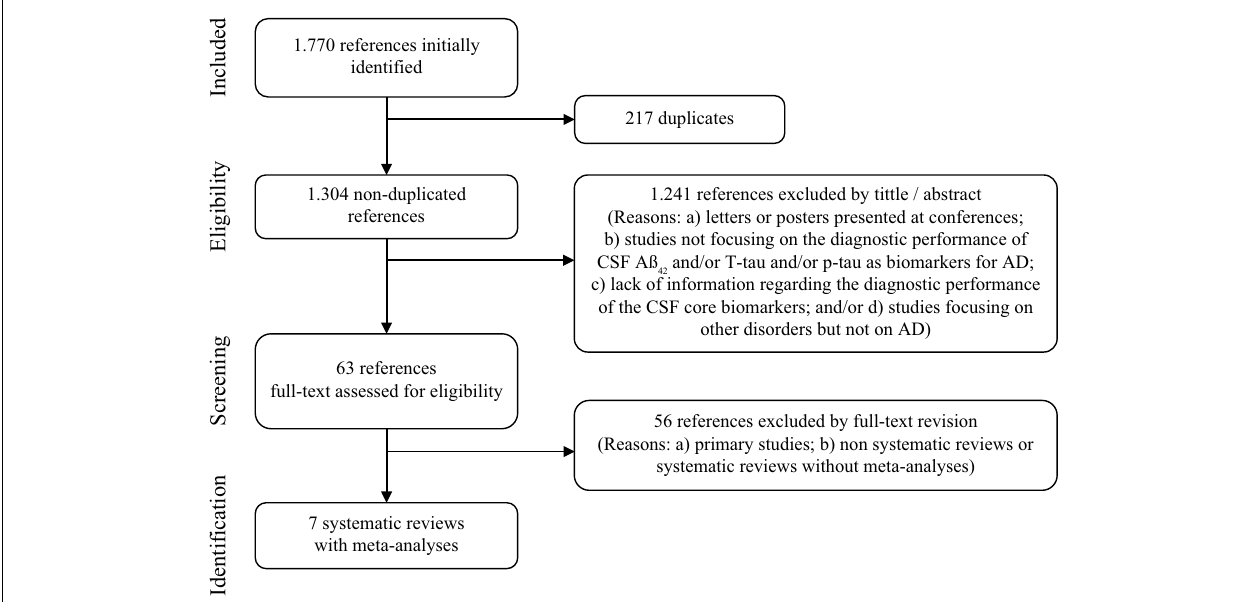
FIGURE 1 | Study selection flow for systematic reviews with meta-analyses